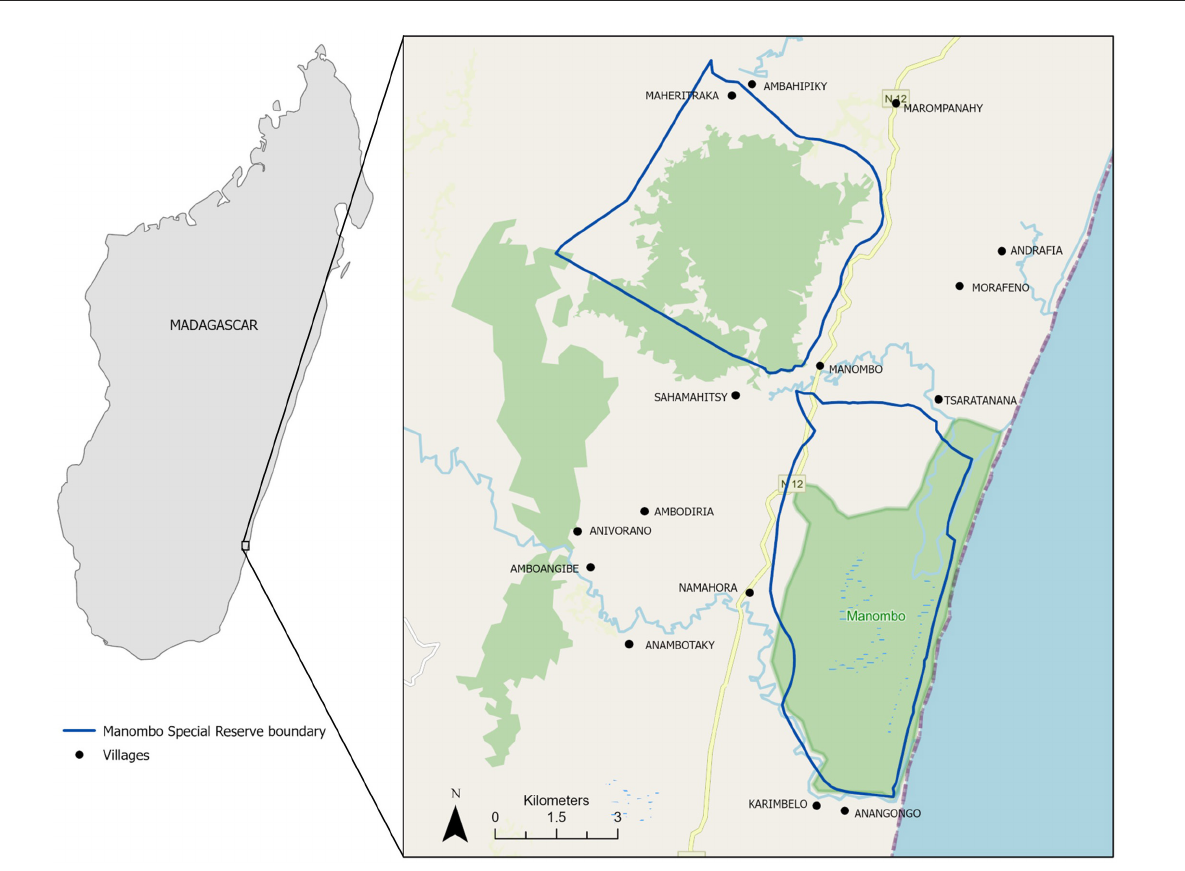
FIGURE2 Map of study area with 15 survey villages, southeastern Madagascar. Black dots are villages with village names. Blue outline denotes Manombo PA boundaries. Green shaded area is remaining forest. Yellow line is